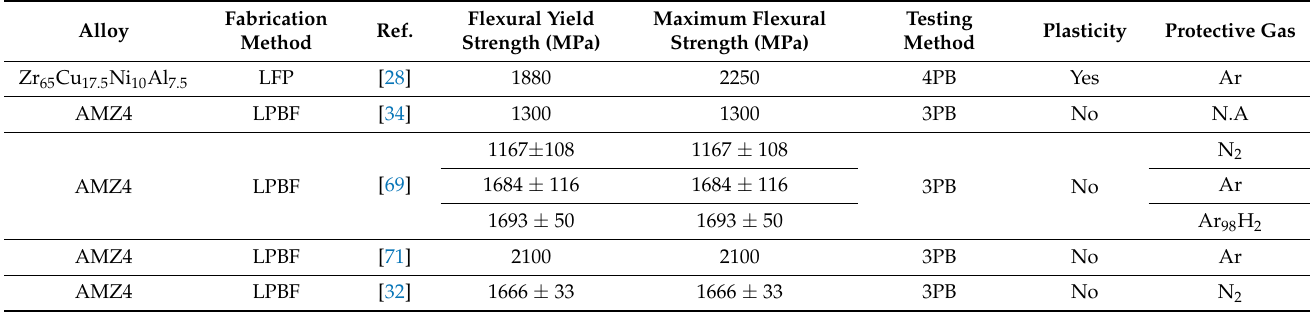
Table 5. Bending test results of BMGs fabricated via AM methods tested with four-point bending (4PB) and three-point bending (3PB).